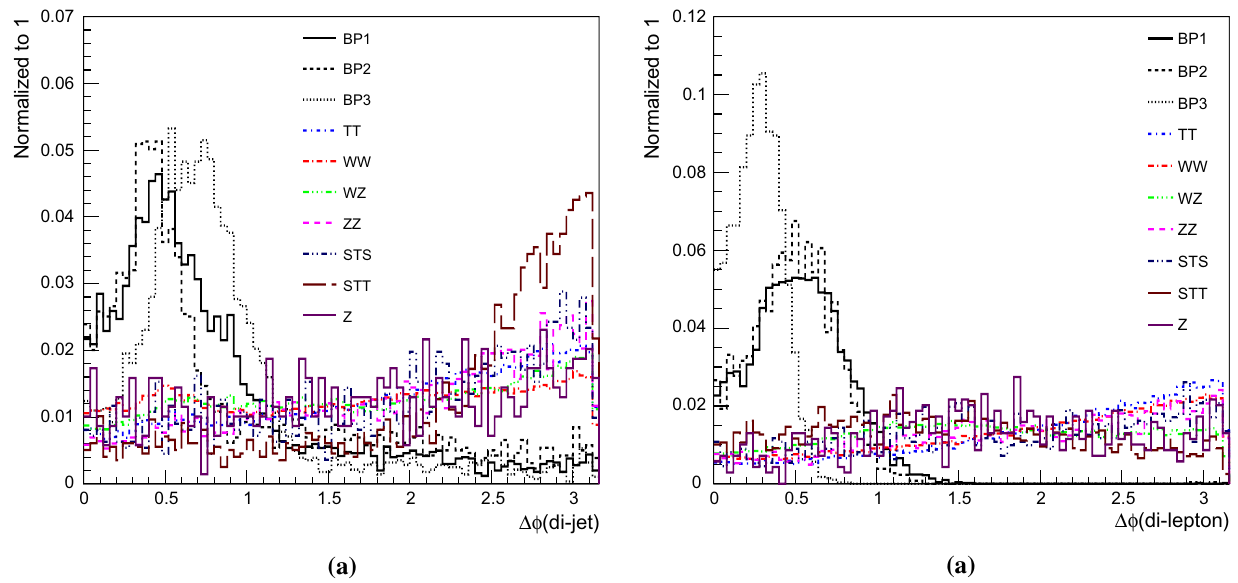
Fig. 5 The distribution of (cid:13)φ between the two jets ( a ) and two leptons ( b ) in signal and background events